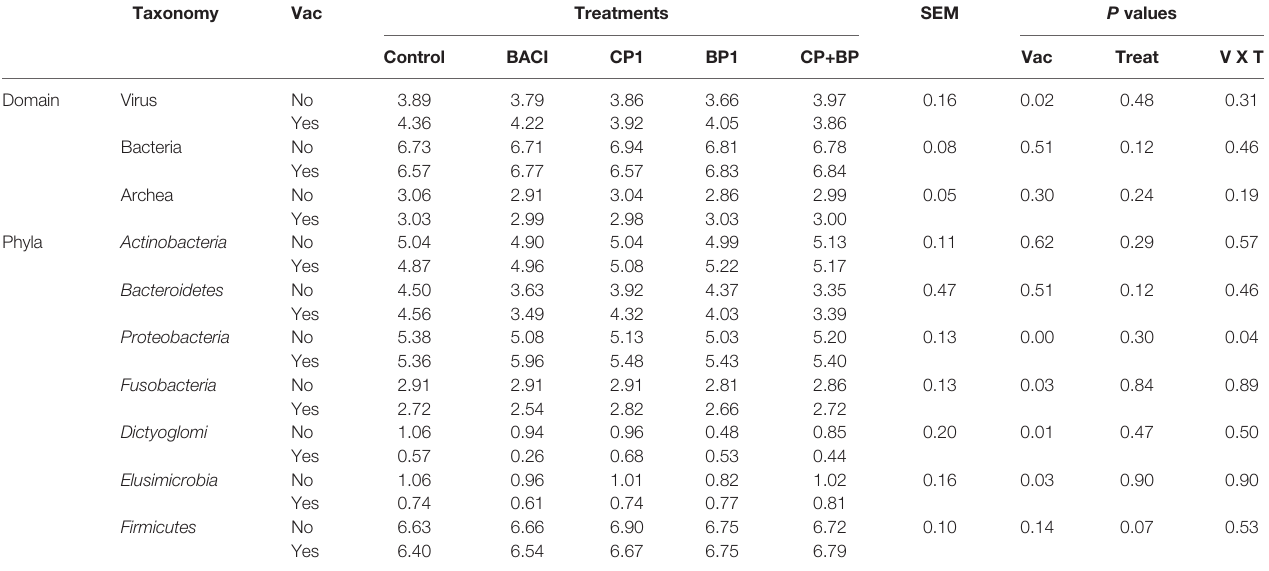
TABLE 5 | Microbial composition in the ceca digesta of 21-day-old broilers at domain and phylum levels signi fi cantly ( P < 0.05) affected by studied dietary treatments. Taxonomy Vac